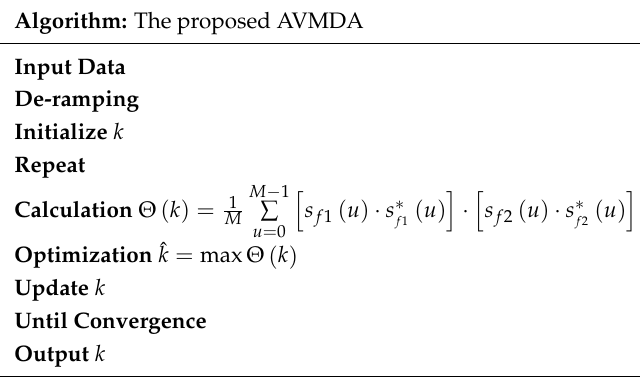
Table 1. Procedure of proposed